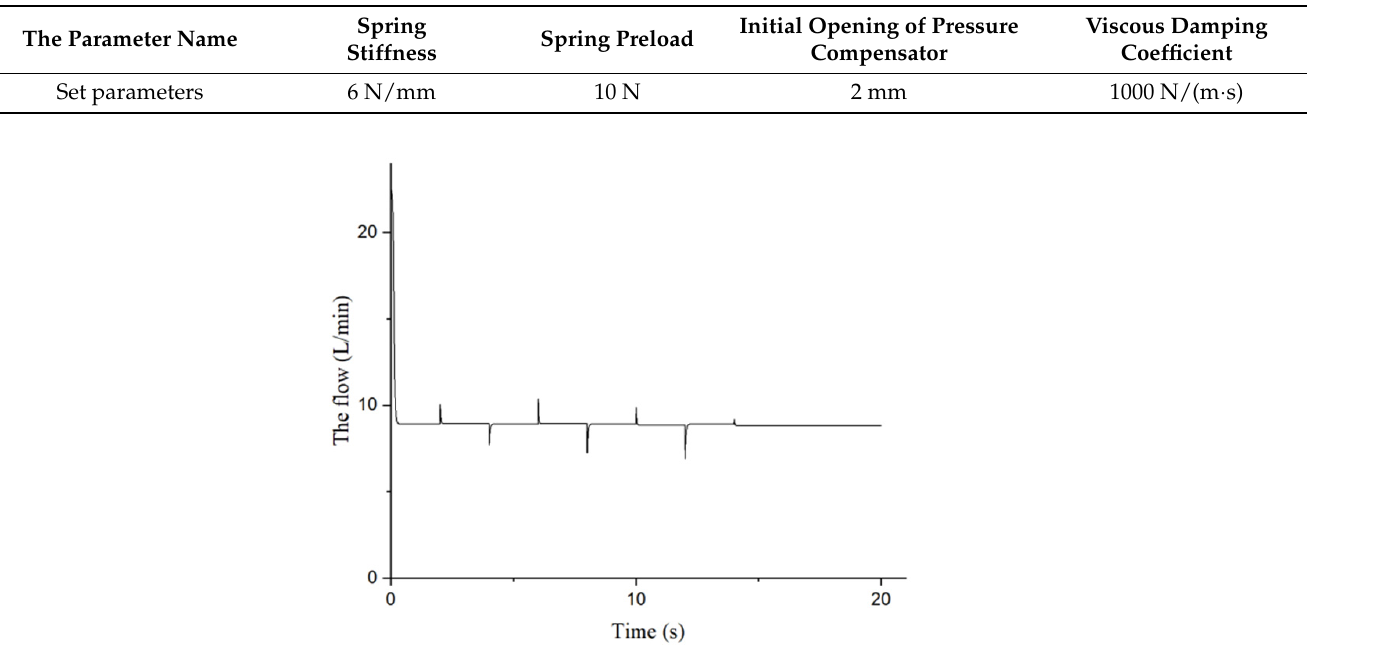
Figure 21. Traffic fluctuation after optimization. Table 3. Selection of parameters related to speed-regulating valve after optimization.